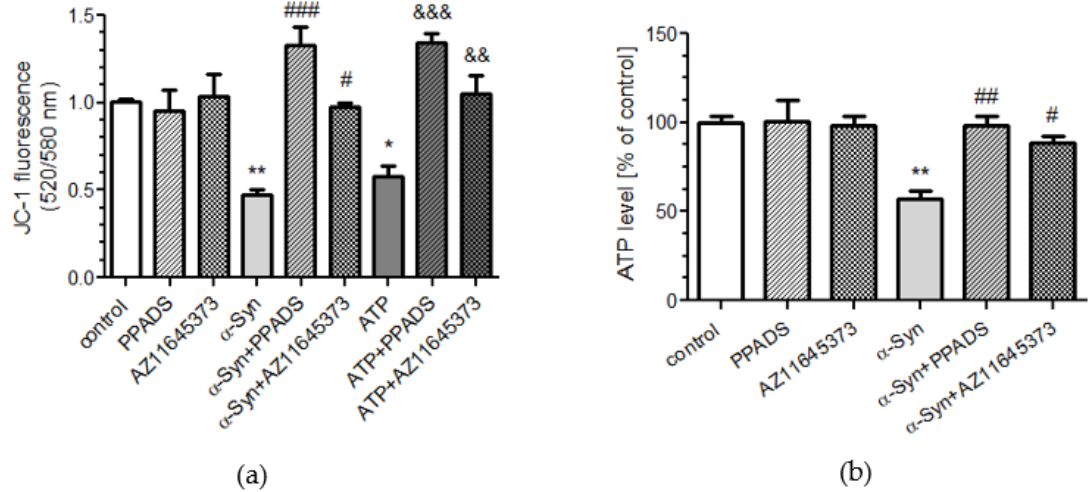
Figure 3. Mitochondrial dysfunction in α -Syn-treated SH-SY5Y cells is mediated by P2X7R activation. ( a ) Mitochondrial membrane potential ( ∆ ψ m) was measured after 10 µ M α -Syn or 1 mM ATP treatment for 8 h in the presence of 100 µ M PPADS or 10 µ M AZ 11645373 in SH-SY5Y cells. Data represent the mean value ± S.E.M. for four independent experiments. * p < 0.05; ** p < 0.01 compared to control; # p < 0.05; ### p < 0.001 compared to α -Syn, and && p < 0.01; and &&& p < 0.001 compared to ATP using one-way ANOVA followed by Bonferroni post hoc test. ( b ) ATP levels was measured after 10 µ M α -Syn treatment for 8 h in the presence of 100 µ M PPADS or 10 µ M AZ 11645373 in SH-SY5Y cells. Data represent the mean value ± S.E.M. for four independent experiments. ** p < 0.01 compared to control; #p < 0.05, ## p < 0.01, compared to α -Syn, using one-way ANOVA followed by Bonferroni post hoc test.